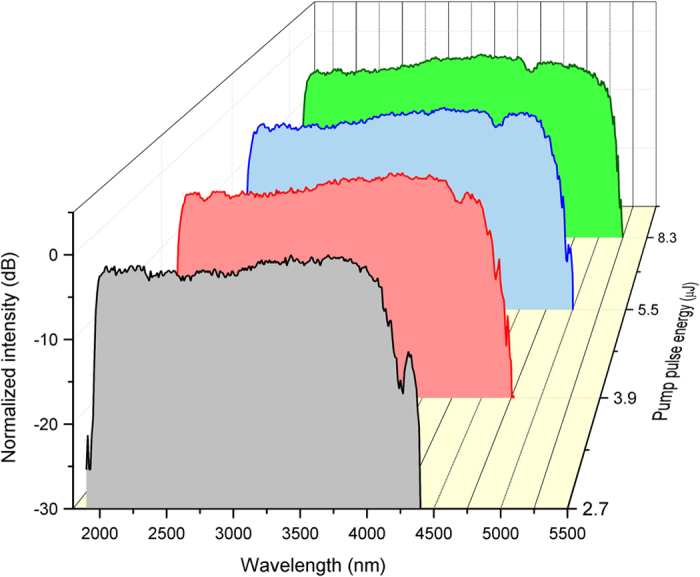
SC spectra obtained from the 9-m-long InF3 fibre pumped at 2.02 μm, recorded for injected pump pulse energies of ~2.7 μJ (36.3 kW), 3.9 μJ (52.4 kW), 5.5 μJ (73.9 kW), and 8.3 μJ (111.5 kW).